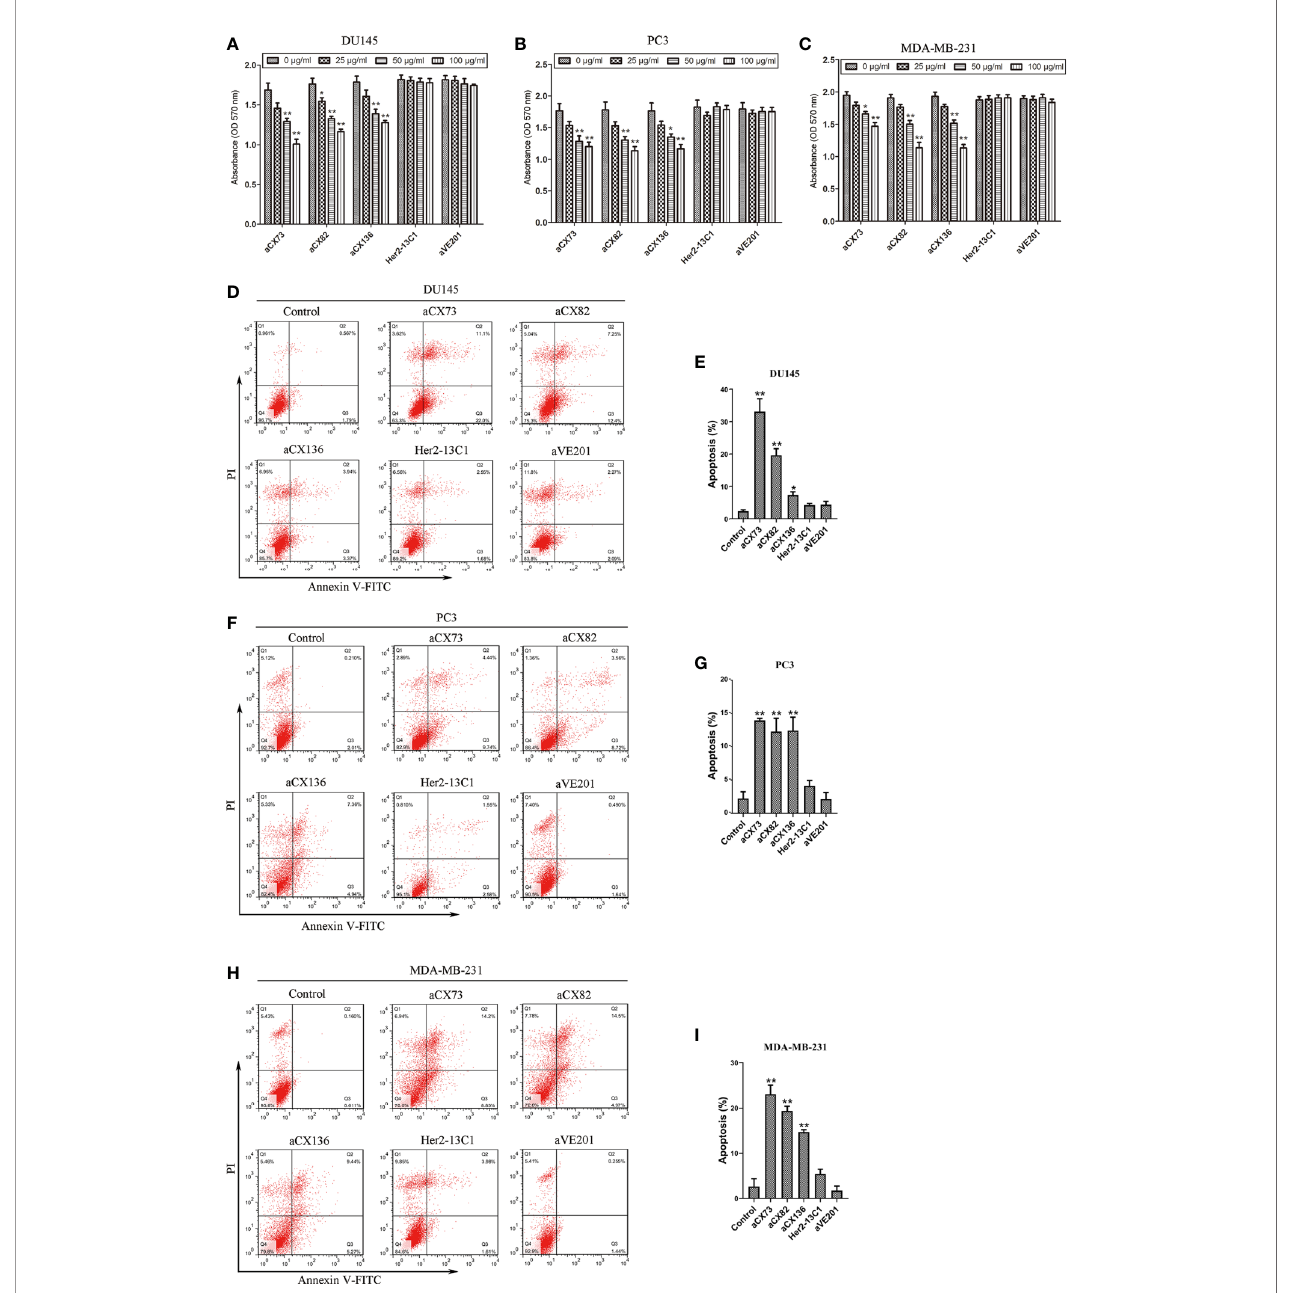
FIGURE 4 | Anti-CXCR4 scFvs can decrease cell multiplication and increase apoptosis. Cell multiplication was examined to detect the inhibitory effect of three anti- CXCR4 scFvs (aCX73, aCX82 and aCX136) on the multiplication of DU145 (A) , PC3 (B), and MDA-MB-231 (C) . Cells were incubated for three days with CXCL12 (100 ng/ml) and the three anti-CXCR4 scFvs or negative control antibodies (Her2-13C1 and aVE201). Detection of apoptosis was carried out for DU145 (D, E) , PC3 (F, G) and MDA-MB-231 (H, I) . Cells were cultured for two days with the CXCL12 (100 ng/ml) and three anti-CXCR4 scFvs or negative control antibodies (Her2- 13C1 and aVE201) (50 µg/ml). Apoptosis was detected by Annexin V-FITC and PI. The results represent mean ± S.D (n=5). * P < 0.05 and ** P <